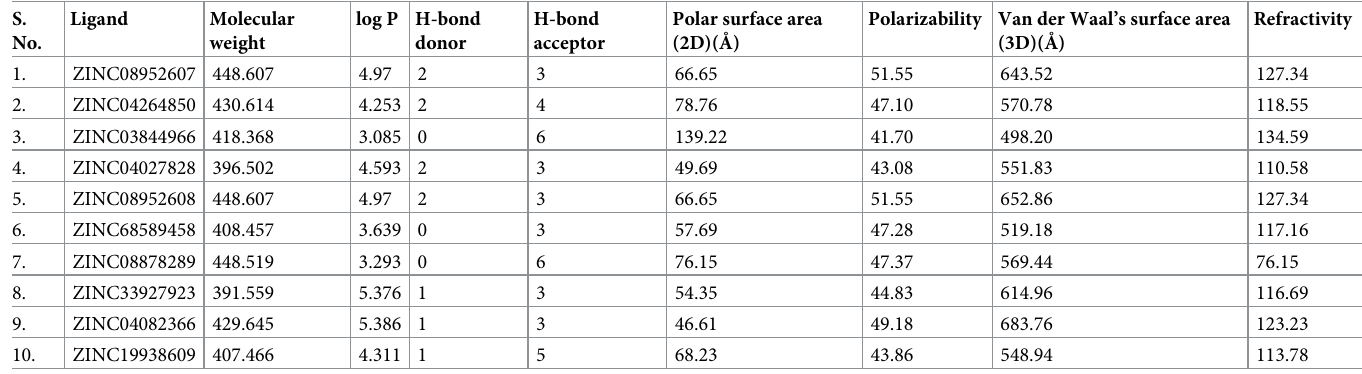
Table 2. Physicochemical properties i.e. molecular weight, LogP, hydrogen bond donor, hydrogen bond acceptor, polar surface area (2D), polarizability, Van der Waal’s surface area (3D), and refractivity of top 10 ligands. S.